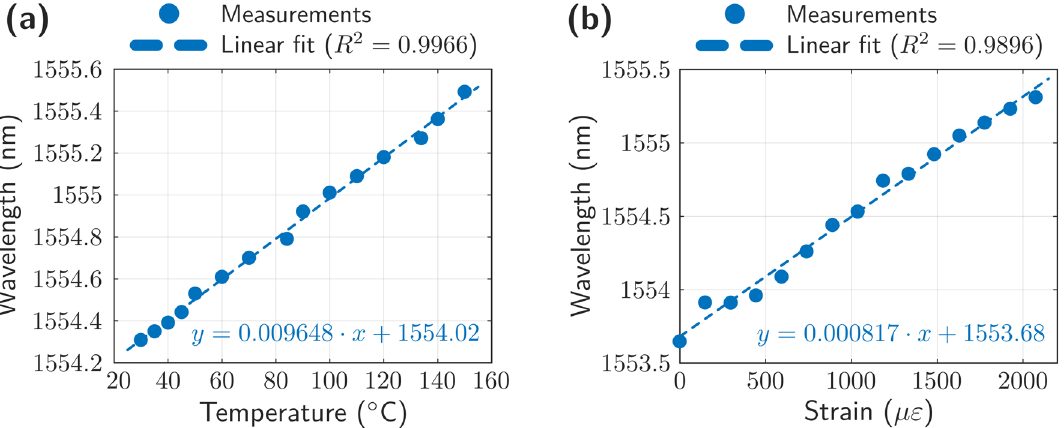
Figure 7. Wavelength shift of the half-open RFL assisted by chirped ACBFRs as a result of ( a ) temperature and ( b ) strain